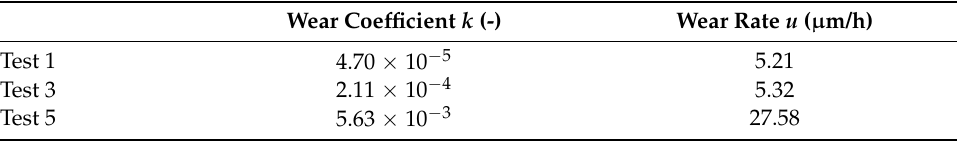
Table 11. Wear coefficient k and wear rate u of Si 3 N 4 ball for R t = 7 mm. Wear Coefficient k